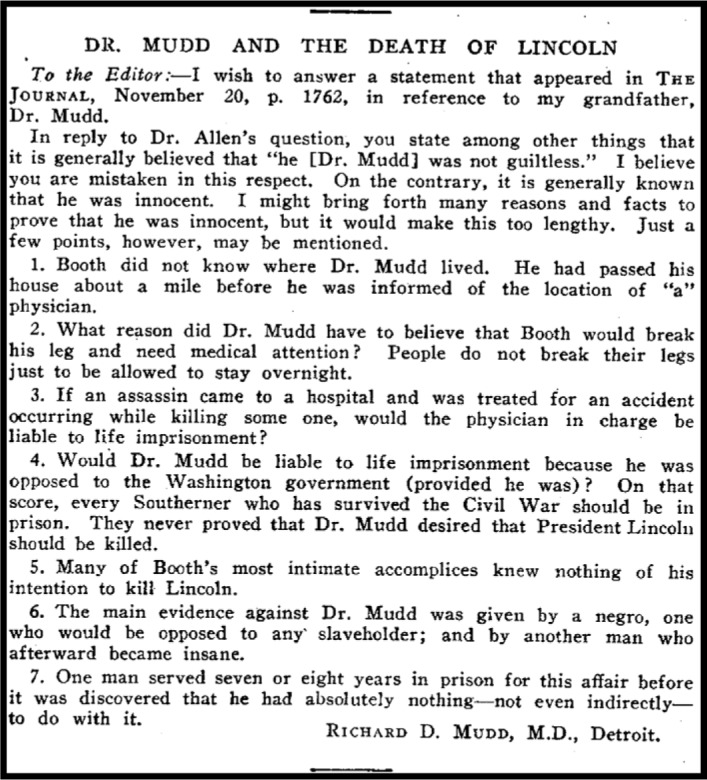
Letter from Dr. Mudd. JAMA. 1927;88:119.